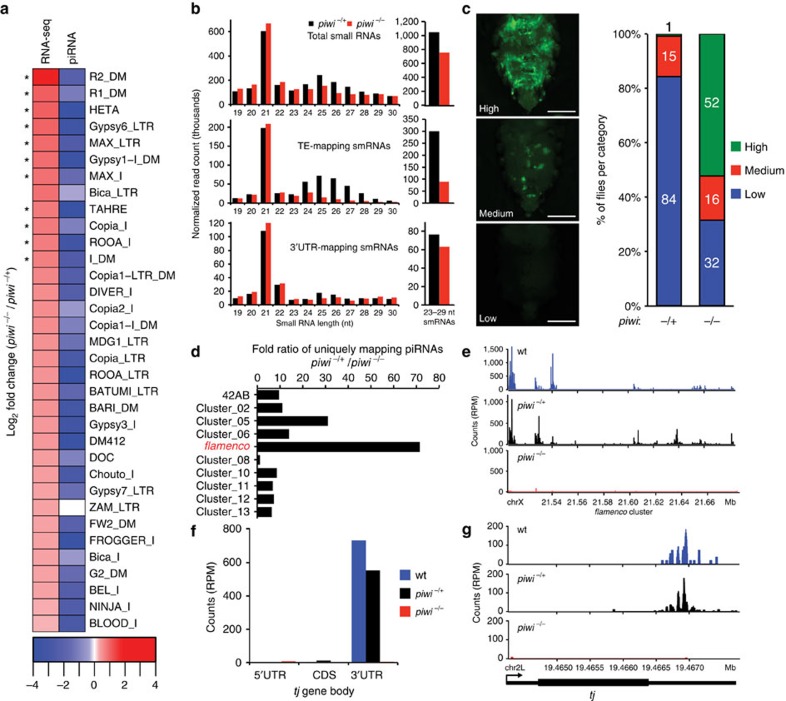
The piRNA pathway is active in the fat body.(a) Heat map of log2 fold change of TE transcript levels (total RNA-seq) >1.2 fold change and corresponding piRNAs (smRNA-seq) in piwi mutant (piwi−/−) compared with heterozygous control (piwi−/+) fat bodies; n=3 replicate libraries. *False discovery rate (FDR) <0.05. (b) Fat body smRNA size profile from oxidized smRNA-seq libraries of piwi mutant fat bodies (red) and heterozygous controls (black). Shown are total smRNAs (top), TE-mapping smRNAs (middle) and 3′UTR-mapping smRNAs (bottom). Panels at right show levels for 23–29 nt smRNAs for each genotype. (c) A fat body-specific transposition reporter line, gypsy-TRAP/r4-GAL4::UAS-GFP, in a piwi mutant background (see Methods). GFP-positive cells are cells in which a transposition event has activated reporter function. The 10-day-old piwi mutants show elevated levels of GFP-positive cells compared with heterozygous controls. Images are of representative flies exhibiting high, medium and low levels of GFP-positive cells (left panels). Scale bars represent 150 μm. Panel on right shows the distribution of flies for each group by genotype; numbers within each bar are corresponding percentages for each group. Fisher's exact test compared the combined ‘High'+‘Medium' groups and the ‘Low' group of each genotype. piwi−/+: n=140 flies; piwi−/−: n=142 flies; P<0.0001. (d) Fold ratio of uniquely mapping cluster piRNAs in piwi mutants compared with heterozygous controls. The flamenco cluster shows the greatest response to loss of piwi. (e) Unique piRNA reads (23–29 nt) map to the flamenco locus in wild-type (wt) and piwi heterozygotes and are lost in piwi mutants. (f,g) Unique piRNA reads (23–29 nt) map to the tj gene body in wt and piwi heterozygotes and are lost in piwi mutants. Thick lines in gene model (g) represent coding sequence, and thin lines represent 5′ and 3′UTRs. See Supplementary Dataset 2 for raw data.